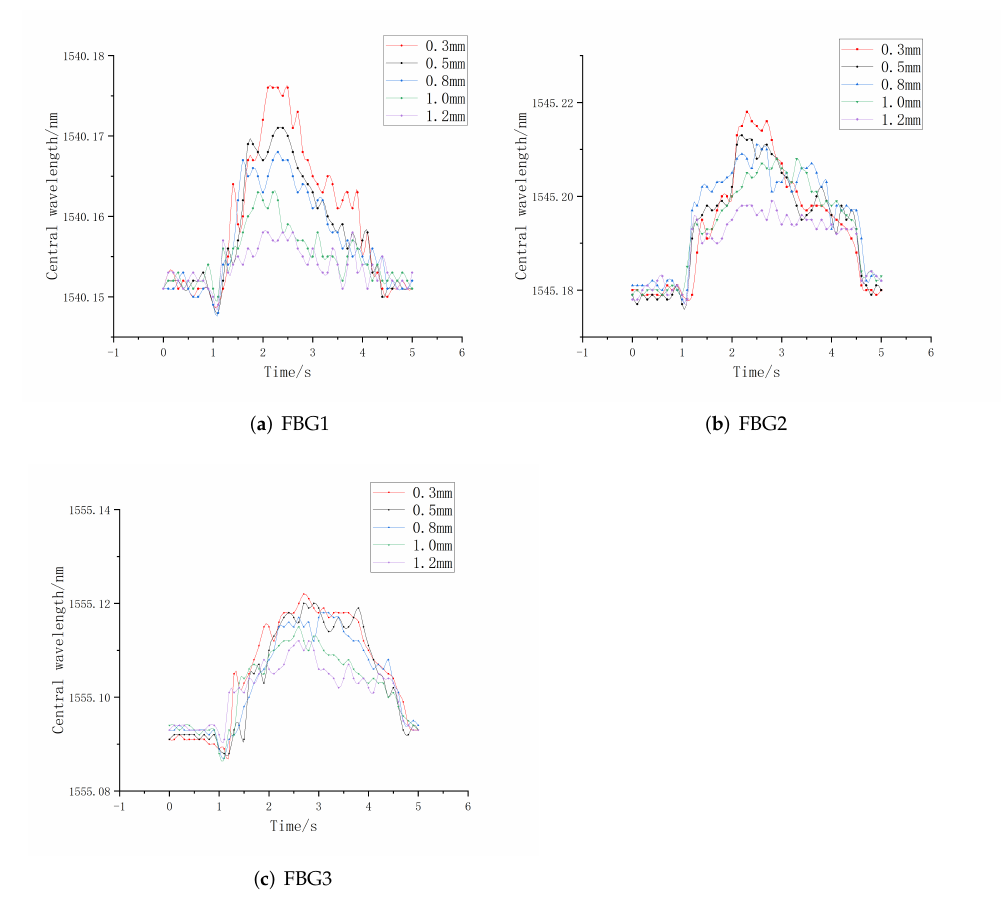
Figure 15. Time-wavelength diagram of